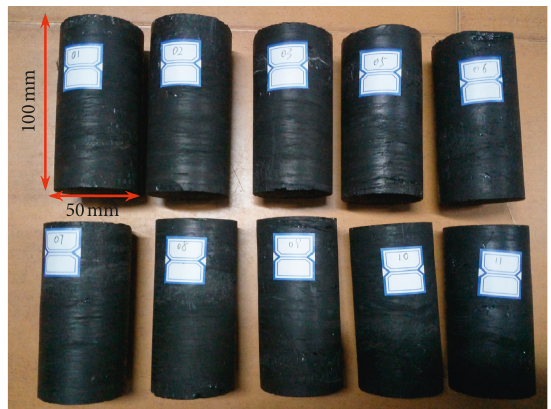
Figure 2: Coal samples.